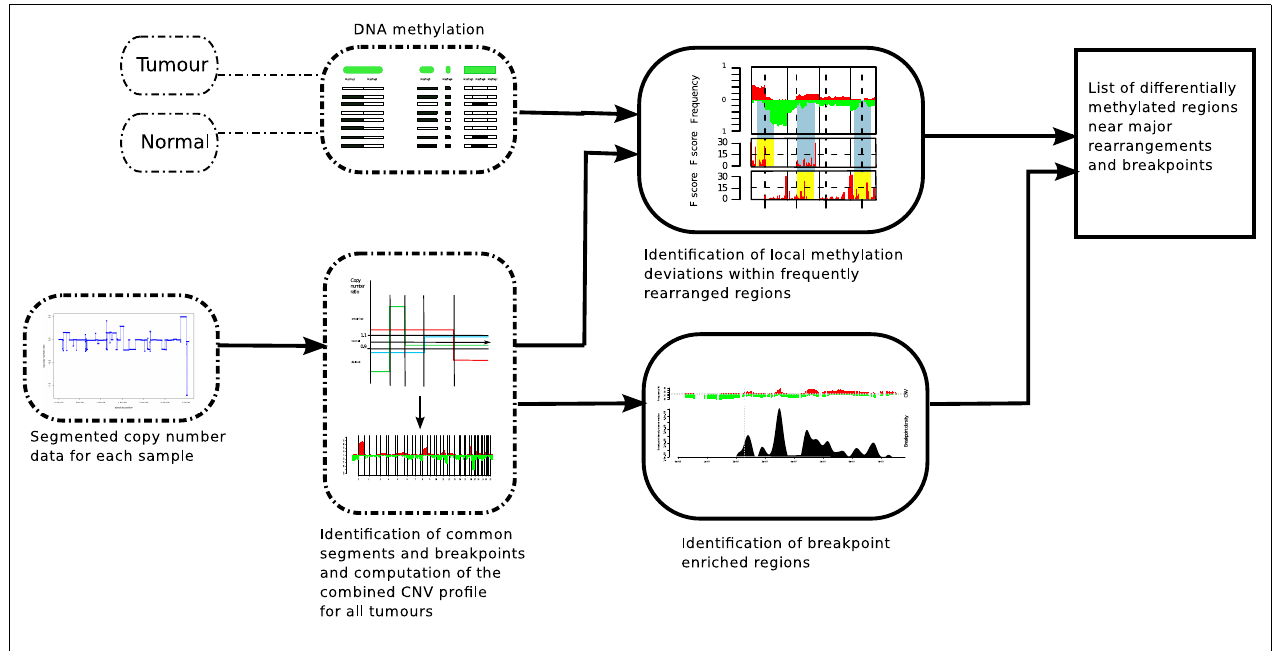
measurements from tumor and Normal samples. A Hotelling’s T 2 -test is performed to identify significant DMRs. On the other track, the locations of BERs are obtained from the ROMA profiles and the list of both significant DMRs and BERs are further evaluated for statistical association ( Figure 3